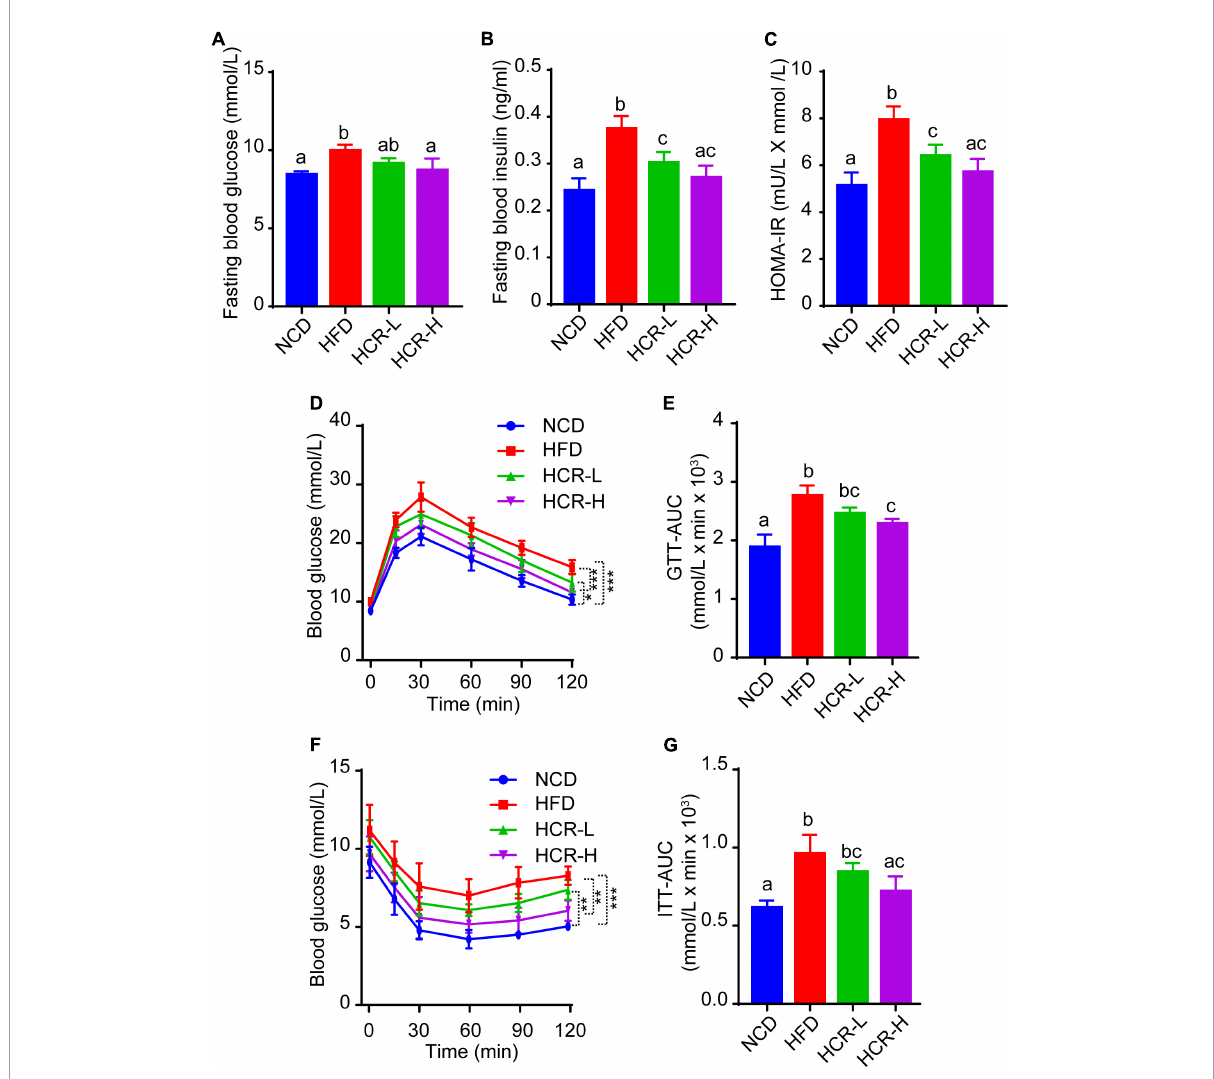
FIGURE3 Cori improved glucose intolerance and insulin resistance in HFD-fed mice. (A) Levels of fasting blood glucose, and (B) levels of fasting insulin were detected in indicated groups. (C) HOMA-IR was calculated with the formula: [fasting glucose (mU/L)* fasting insulin (mmol/L)]/22.5. (D) Glucose tolerance test (GTT) was examined, and (E) the area under the curve (AUC) for GTT was calculated. (F) Insulin tolerance test (ITT) was tested, and (G) the area under the curve (AUC) for ITT was calculated.